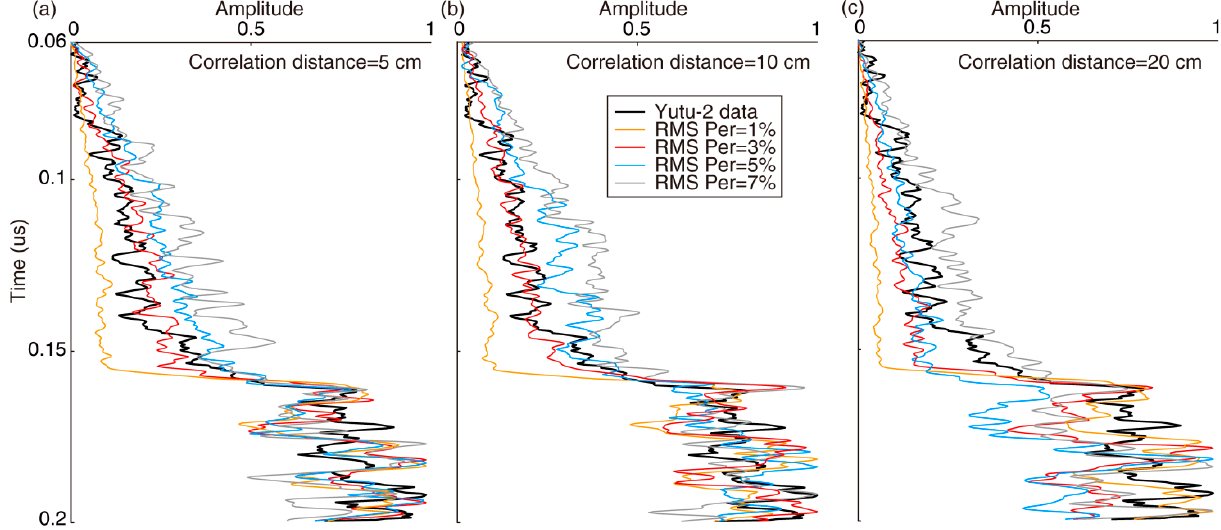
Figure 11. Comparison between stacked envelopes of the observed and synthetic LPR data using different correlation distances and RMS perturbations. ( a ) Correlation distance is 5 cm. ( b ) Correlation distance is 10 cm. ( c ) Correlation distance is 20 cm. The amplitude is normalized for each stacked envelope.